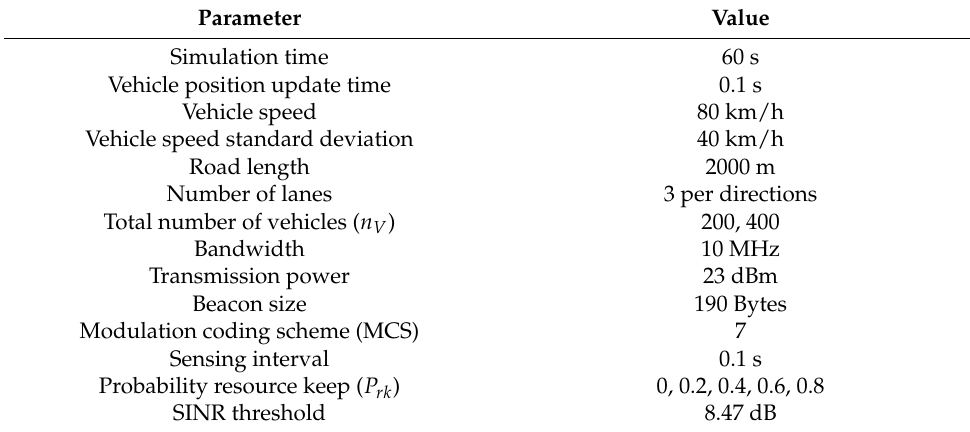
Table 2. Parameter settings.